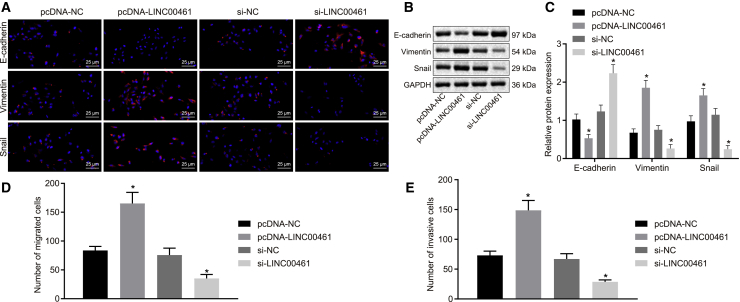
LINC00461 induces the EMT process in HNSCC(A) Immunofluorescence detection of EMT-related factors E-cadherin, Snail, and Vimentin in the HNSCC cell line FADU (400×). Three groups of red fluorescence represent E-cadherin, Snail, and Vimentin proteins, respectively, and blue fluorescence represents nuclei. (B) The protein bands of EMT-related factors E-cadherin, Snail, and Vimentin in the HNSCC cell line FADUs. (C) Quantitative analysis of (B). (D) The number of migrated FADU cells. (E) The number of invasive FADU cells. All of the data are measurement data and expressed as means ± standard deviations. The data among multiple groups were compared using 1-way ANOVA. The experiment was conducted 3 times independently. ∗p < 0.05 versus the pcDNA-NC group or the si-NC group.